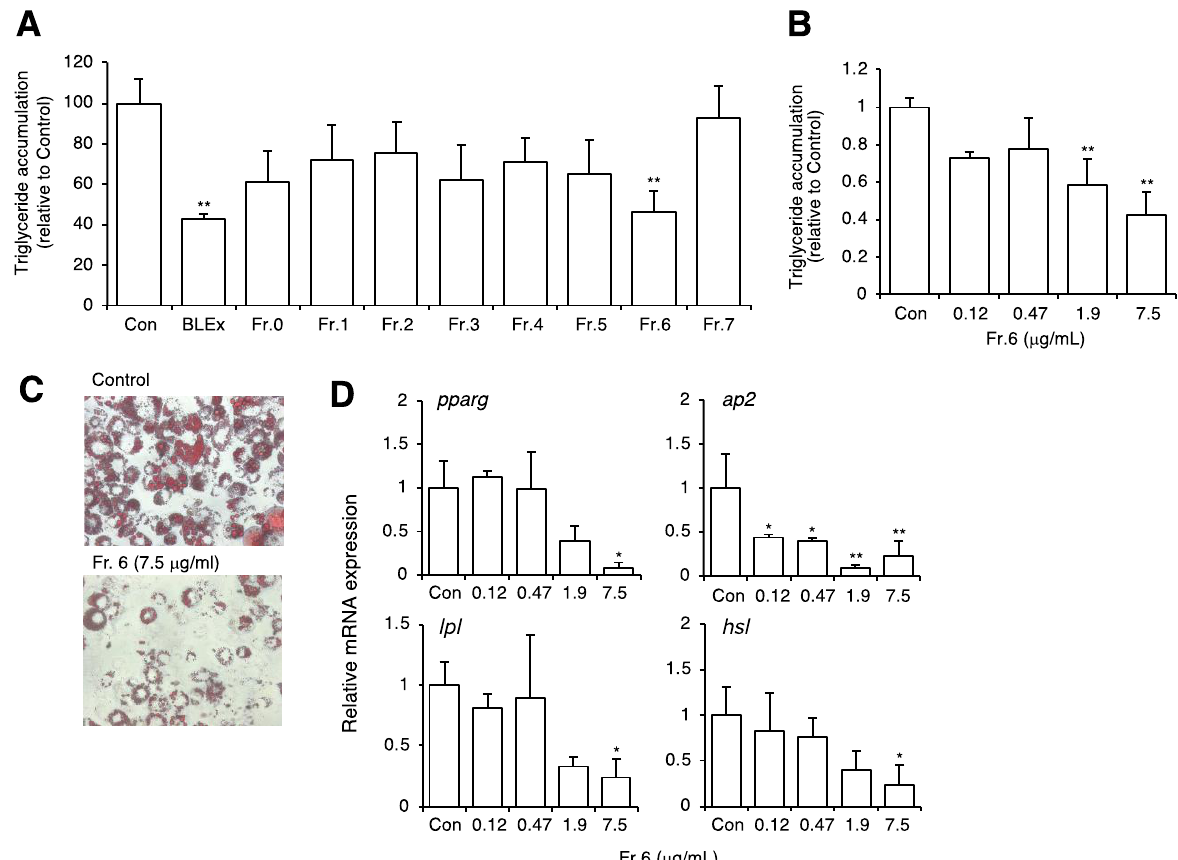
Figure 3. Effect of fractionated BLEx on the differentiation and maturation of 3T3-L1 cells to adipocytes. Data are means ± SE for 3 independent experiments. Statistical analysis was performed using one-way analysis of variance (ANOVA) and post hoc tests (Tukey–Kramer multiple comparisons). Asterisks indicate a significant difference compared to the control at p < 0.05 * or p < 0.01 **. ( A – C ): Lipid accumulation was evaluated by Oil Red O staining and representative images are shown in C. ( B ) shows the dose dependent effect of Fr. 6. ( D ): mRNA expression of adipocyte differentiation markers was measured by real-time PCR, and the data are shown as values relative to the mRNA expression of the internal control, gapdh